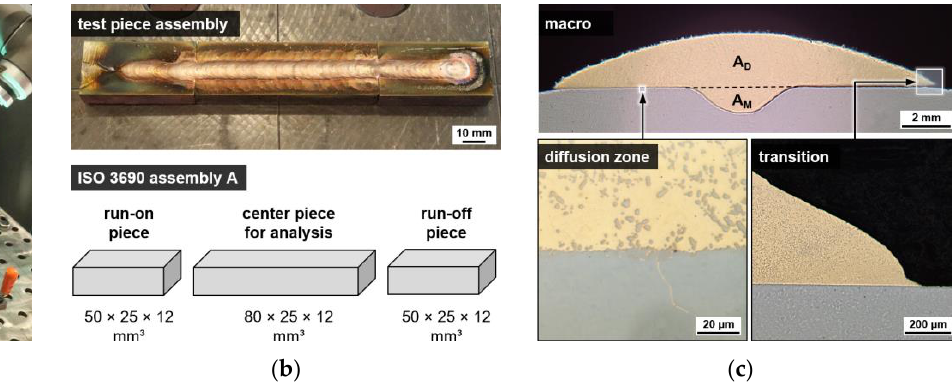
Figure 2. Production of specimens, ( a ) arc brazing of test piece assembly, ( b ) test piece for hydrogen analysis and ( c ) cross section of the test piece.